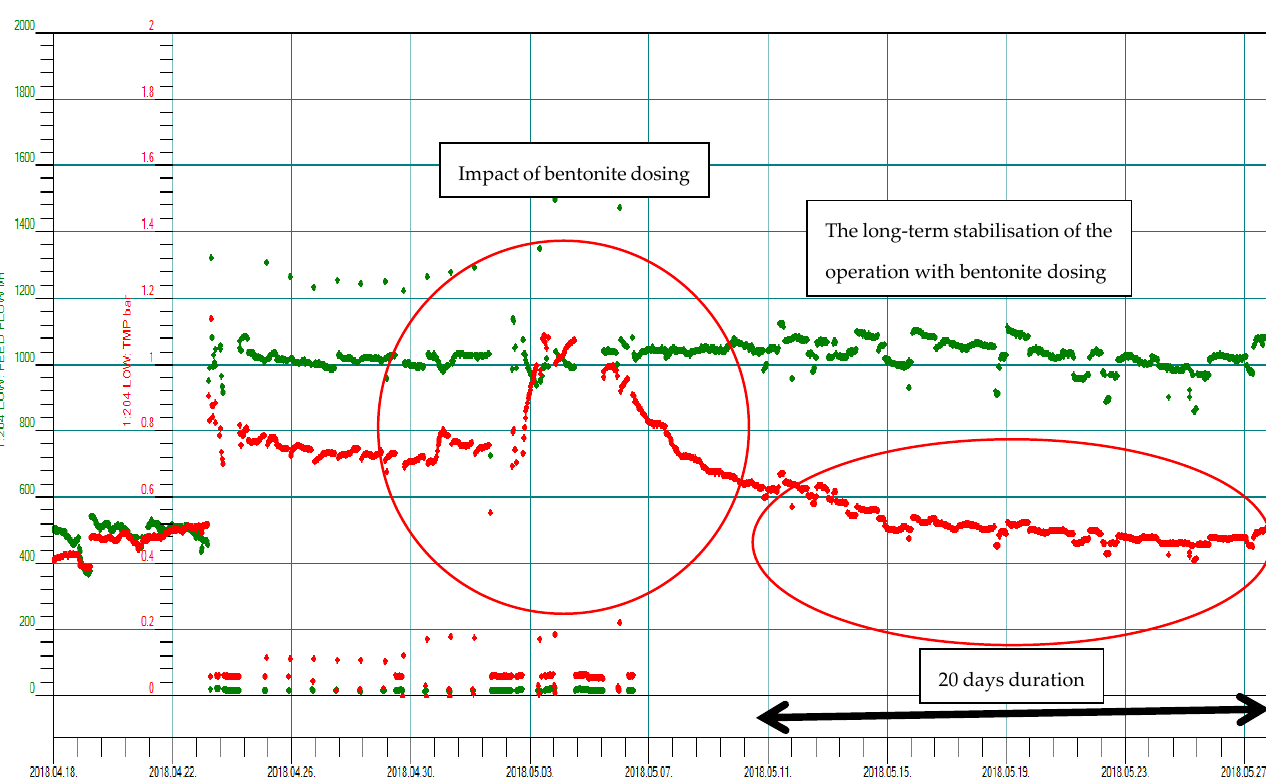
Figure A10. Flow and TMP—the impact of bentonite dosing.